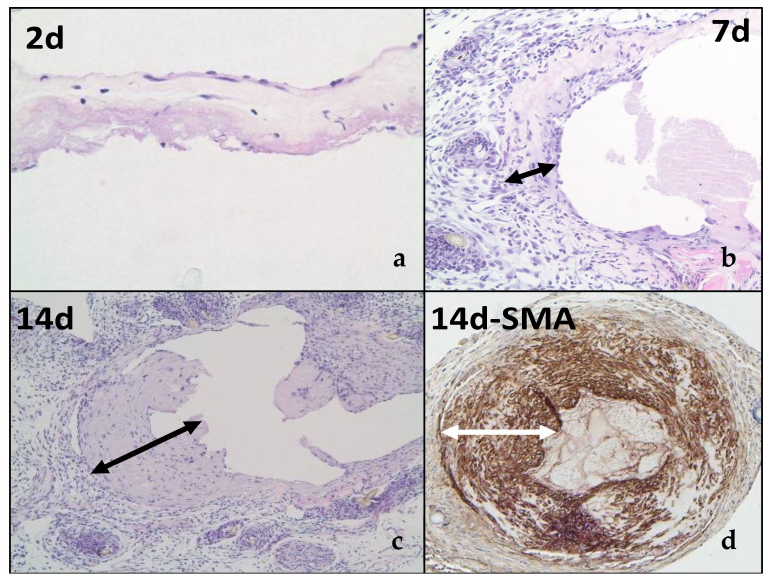
Figure 1. Mouse AVF Model Histology: ( a – d ) Note the rapid increase in neointimal hyperplasia from 2 d to 7 d to 14 d. Double-headed arrows in white and black indicate the extent of the neointimal hyperplasia; SMA = smooth muscle alpha